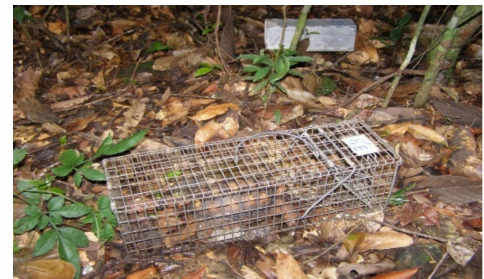
Figure 2. Tomahawk-type